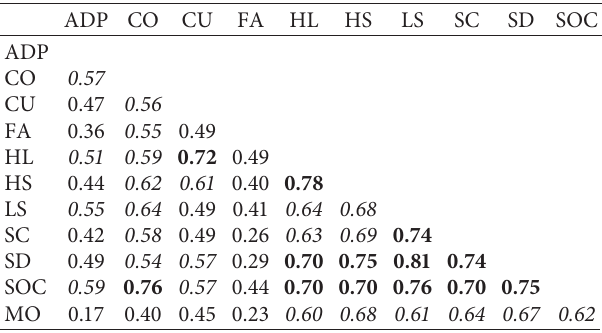
Table 2: Pearson product-moment correlation matrix ( N � 273).